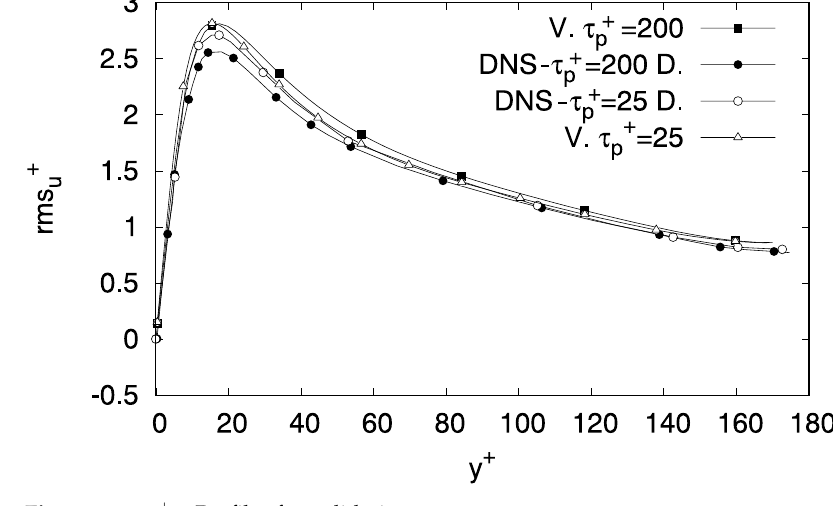
Figure 3. rms + u —Profiles for validation cases.